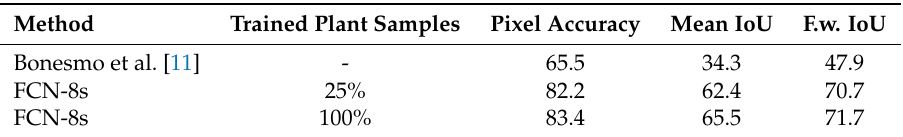
Table 1. Comparison of the approach by Bonesmo et al. [11] and the obtained results of FCN-8s on simulated images. Our results are presented when using all 195 plant samples (100%) to simulate clover grass images and when using only 25% of the samples. IoU: intersection over union. F.w: frequency